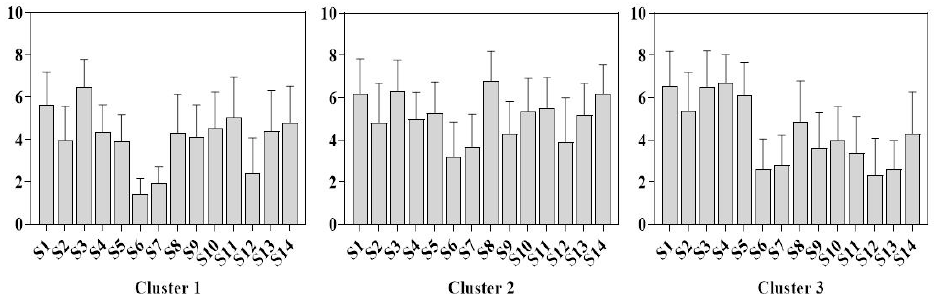
Figure 5. K-means clustering analysis of preference scores for fourteen milk powder samples currently available in the Chinese market.